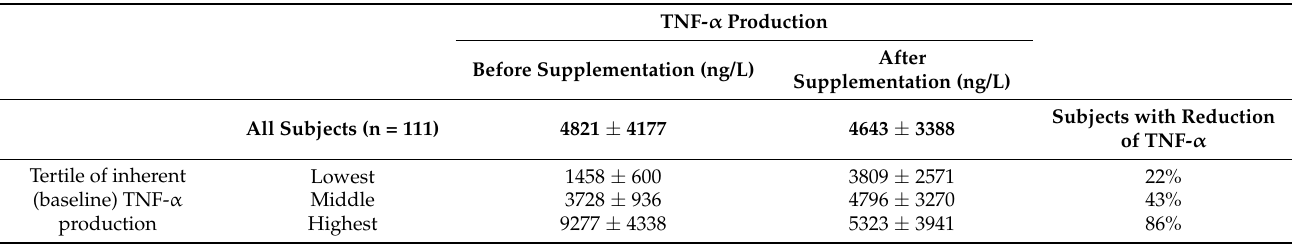
Table 1. Response of TNF- α production levels by various tertiles of inherent baseline TNF- α